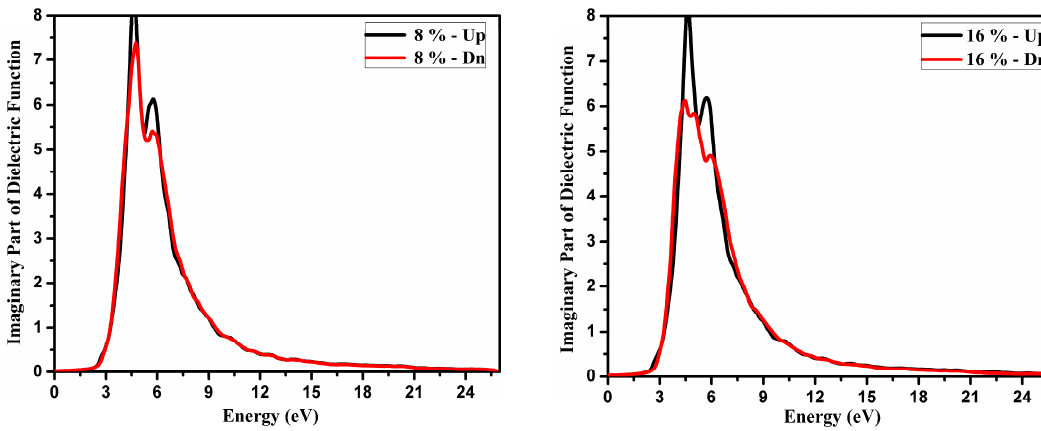
Figure 5. Calculated imaginary part (dark solid curve ‐ black color for up spin) and (long solid curve ‐ red color for down spin) spectra of Mn x Zn 1 − x Te (x = 8% and 16%).